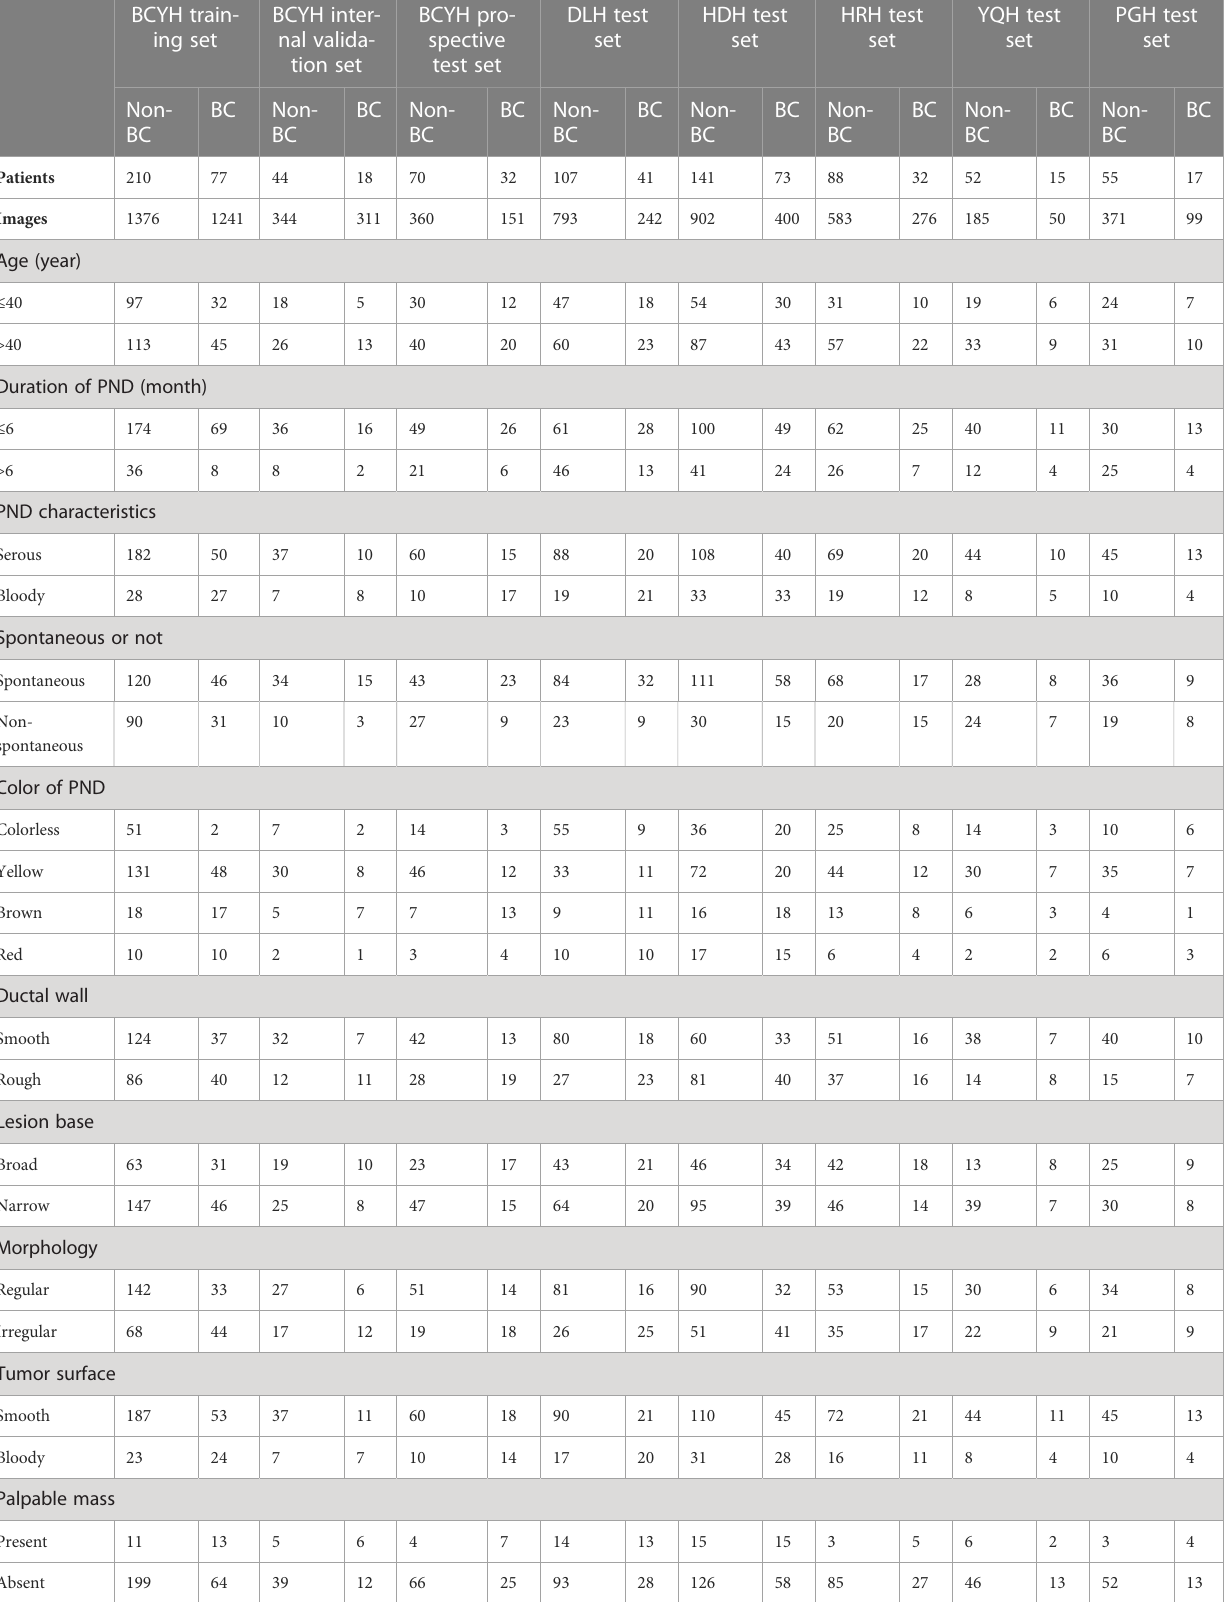
TABLE 1 Baseline